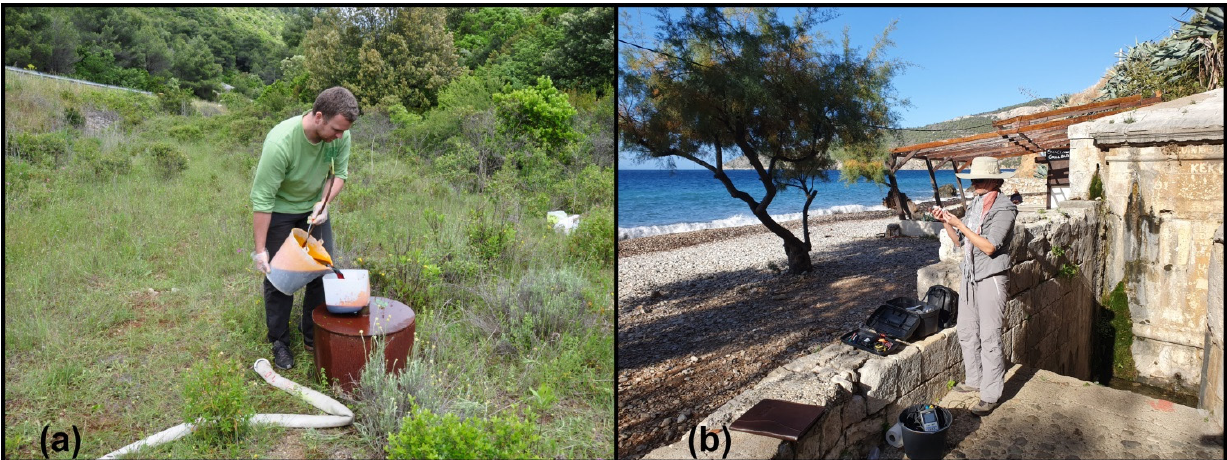
Figure 6. Activities performed in the scope of research: ( a ) tracer test (dye injection); ( b ) water sampling at Kamenice spring.